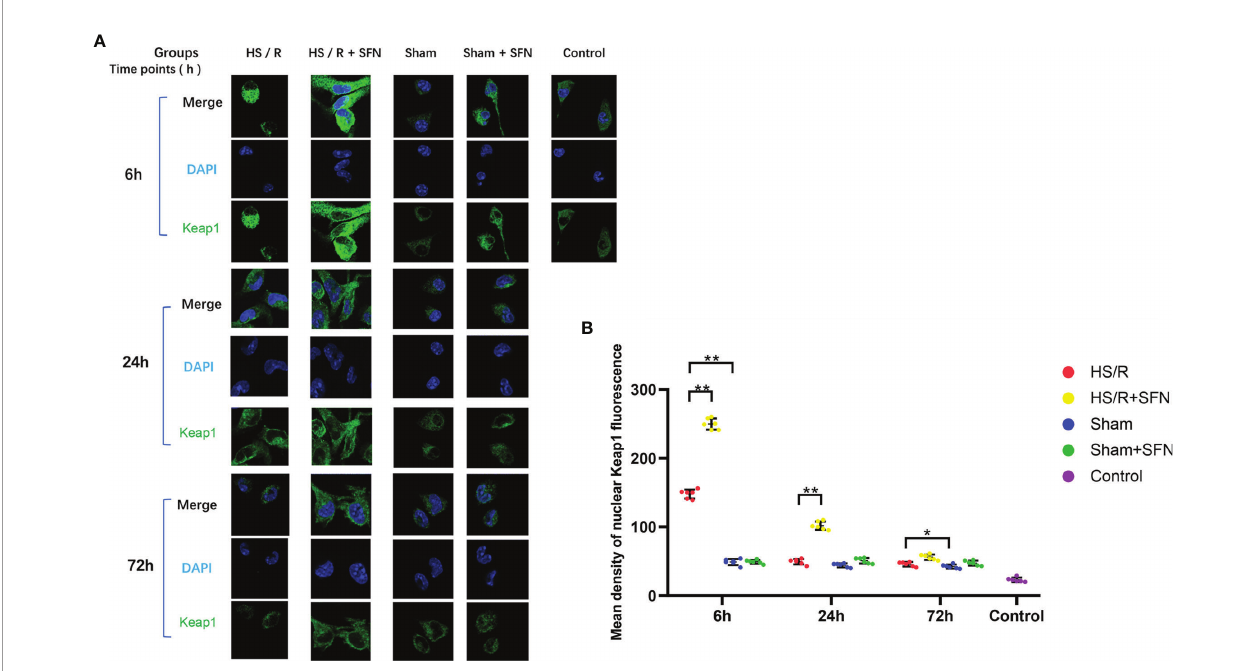
FIGURE 3 | Immuno fl uorescence analysis of cytoplasmic Keap1 (n=6 in each group). (A) Kupffer cells were isolated from the WT mice of different groups and fi xed immediately. Keap1 was targeted with a primary anti-Keap1 antibody and visualized with a goat anti-Rabbit DyLightH 488-conjugated secondary antibody. The nuclei were stained with DAPI, and the images were taken using confocal fl uorescence microscopy. (B) The quantitative analyses of the mean density of fl uorescence in the nuclei were performed with the AxioVision Rel. 4.8 software (Carl Zeiss Micro Imaging, LLC) (*p < 0.05, **p < 0.01; One-way ANOVA followed by Tukey ’ s post hoc test).